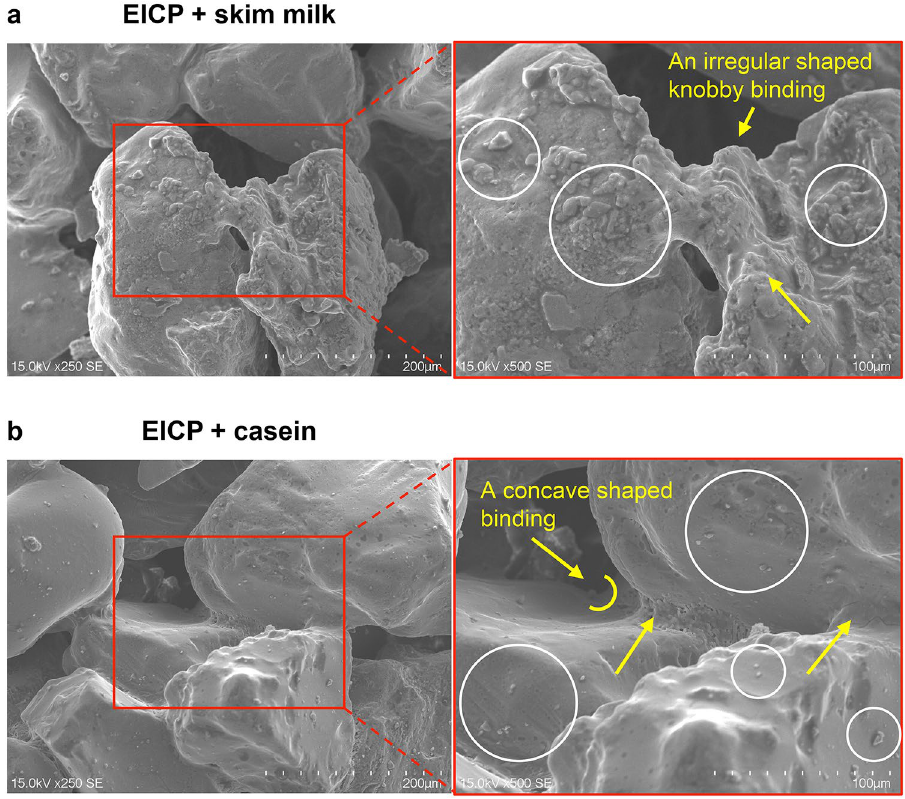
Figure 6. SEM images of the EICP-biocemented specimens assisted using skim milk ( a ) and casein ( b